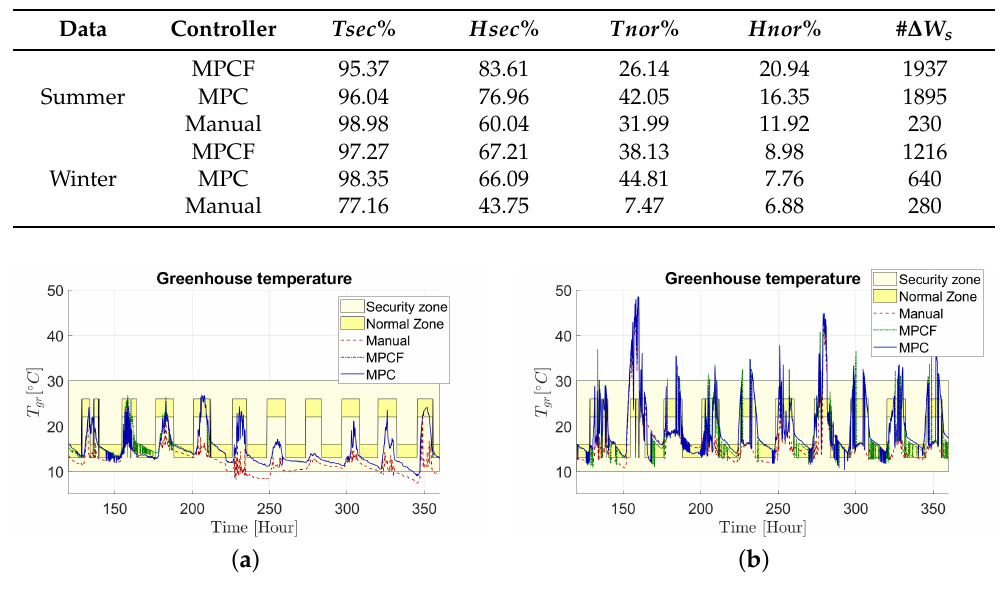
Figure 7. Temperature obtained inside the greenhouse during the simulations. Both results were compared with the values in the corresponding normal and security zones defined for this climatic variable. These simulation results were obtained using climate data from the winter and summer seasons. ( a ) Temperature inside the greenhouse T gr when using winter data; ( b ) temperature inside the greenhouse T gr when using summer data.